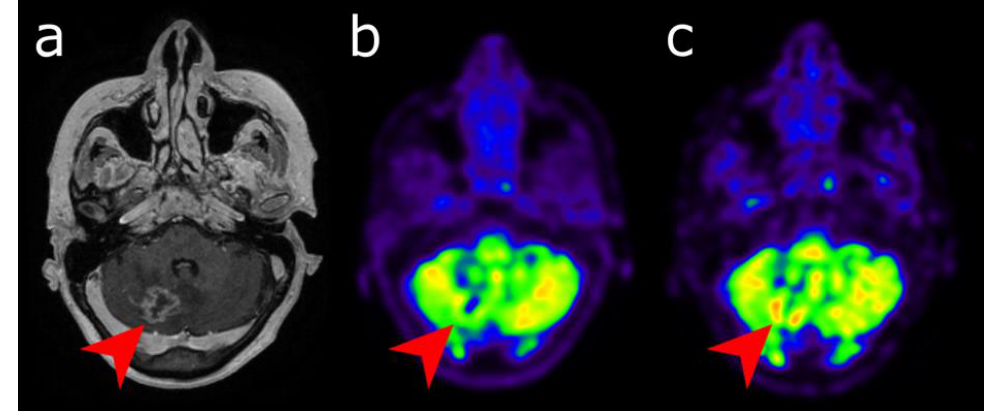
Figure 3. Differential diagnosis between recurrence versus radionecrosis in a 73-year-old woman who was treated with stereotactic radiation therapy 2 years earlier for a cerebellar metastasis (red arrow) of breast cancer. Post-enhancement T1-weighted MRI ( a ) revealed an increasing contrast enhancement. While standard [18F]FDG PET imaging performed 60 min ( b ) displayed no significant uptake, delayed images performed 4 h post-injection ( c ) revealed uptake higher than the background activity, suggesting tumor recurrence.